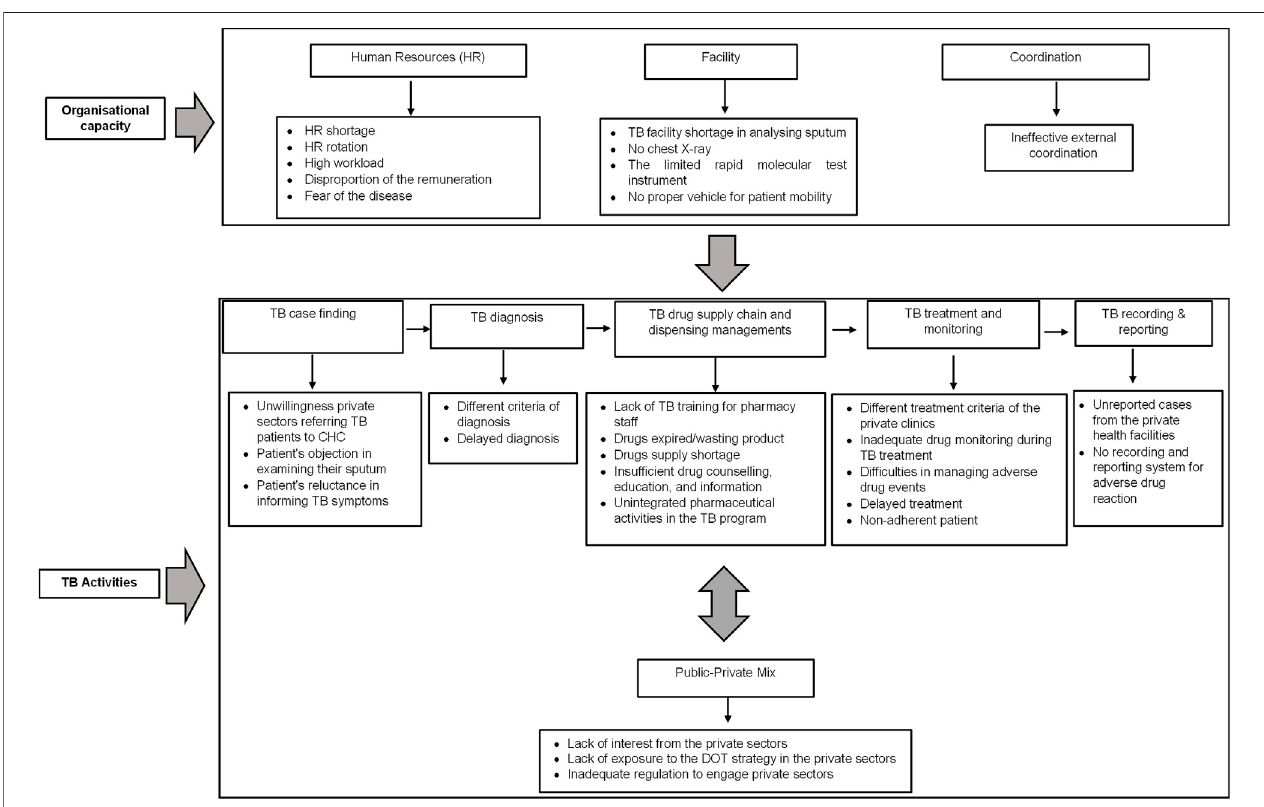
FIGURE 2 | Theme, sub-theme, and code of barriers to successful TB treatment from the TB service provider perspectives.